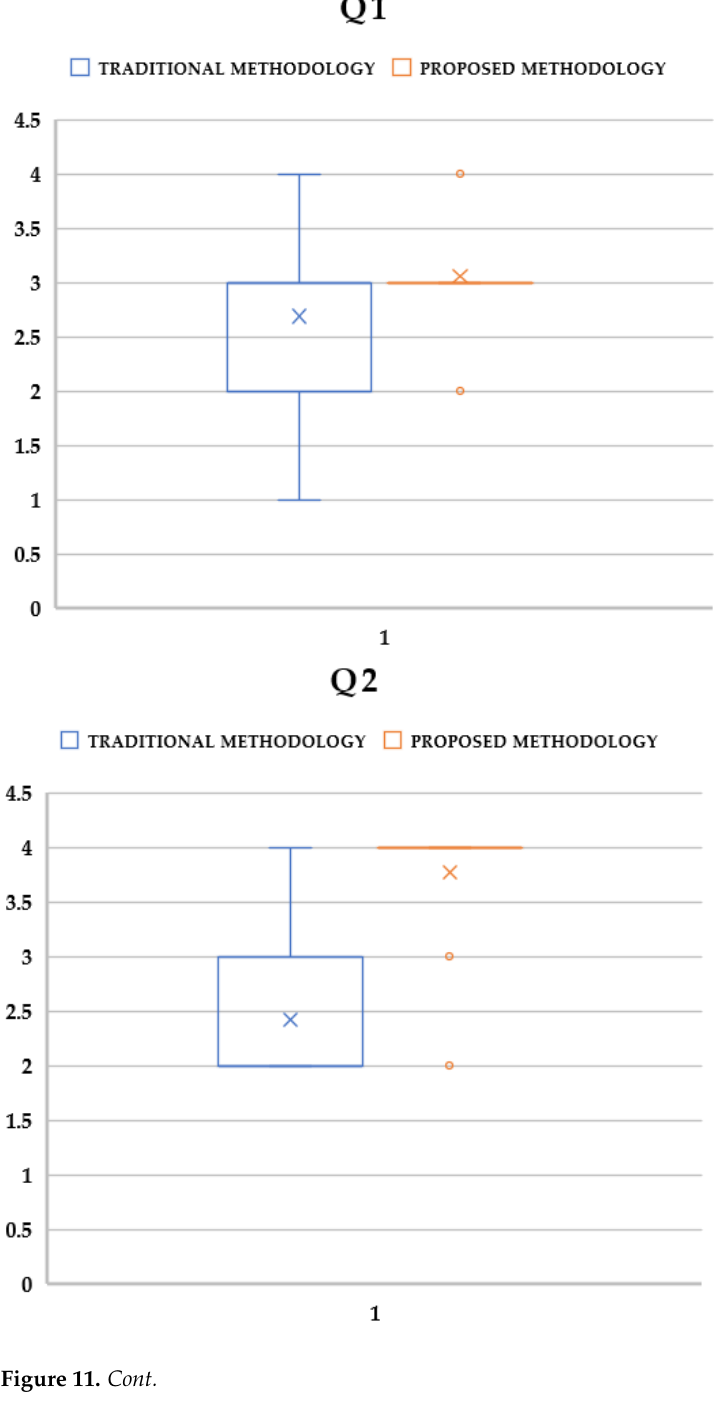
Figure 10. Survey results.